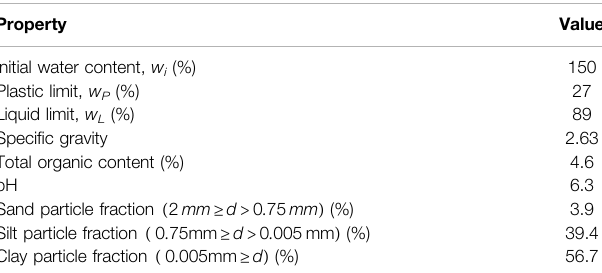
TABLE 1 | Physical and chemical indexes of